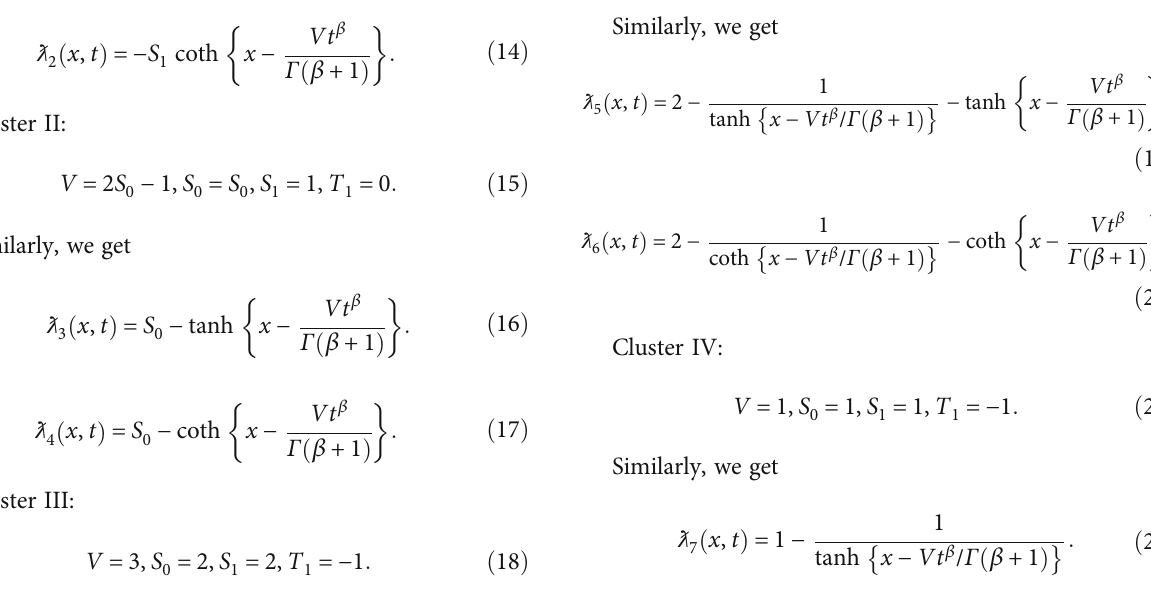
Figure 4: The graphical representation of the solution ƛ real contour plot, and (d) imaginary contour